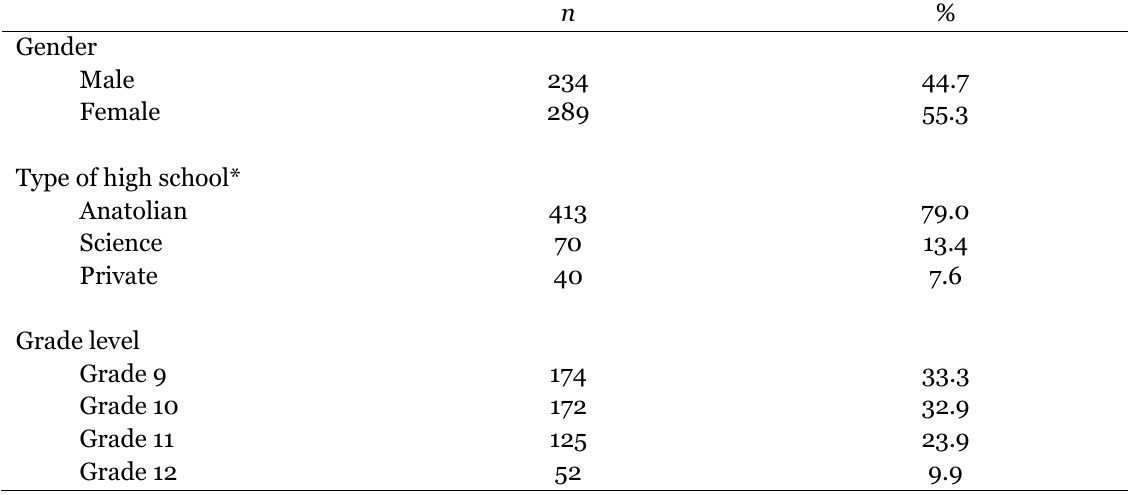
Individual and School Characteristics of First Study